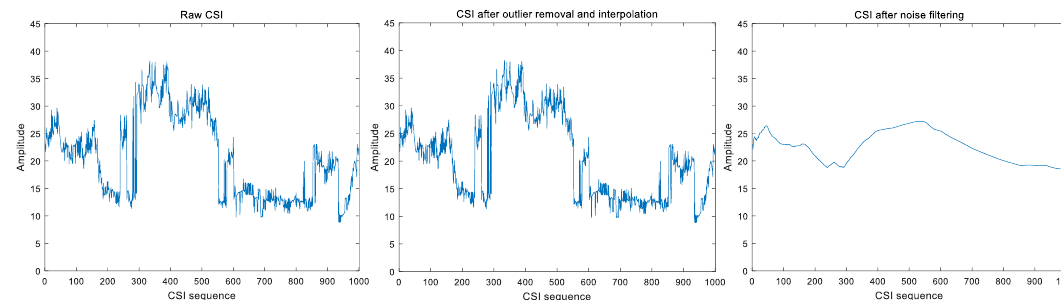
Figure 4. Intrusion in indoor static environment.